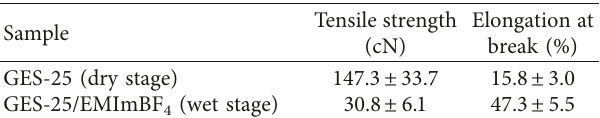
Table 2: Comparison of the mechanical properties of GES-25/ EMImBF 4 and